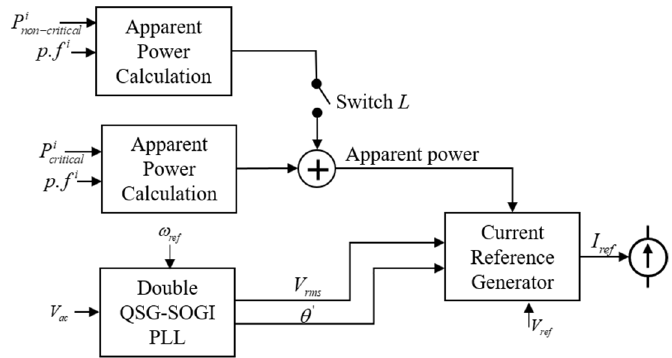
Figure 4. The proposed load model.